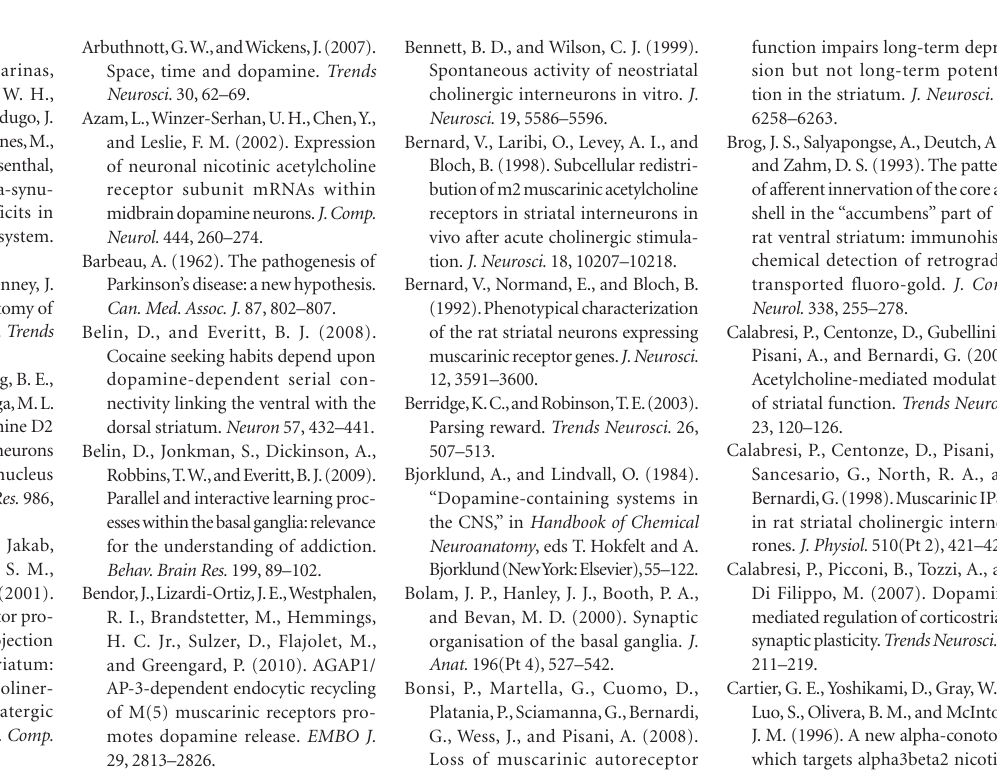
Figure 2 | Scheme illustrating cholinergic regulation of dopamine (DA) release during burst and non-burst activity in DA axons and nAChr/ mAChr subtypes responsible in CPu and NAc. Left, When mAChRs are inactive under control conditions, endogenous acetylcholine (ACh) released from tonically active striatal cholinergic interneurons (ChIs) maintains ACh tone at β 2*-nAChRs on dopaminergic axons. This tonic β 2*-nAChR activity ensures that DA release has a high probability of occurring in response to a single stimulus pulse. Short-term synaptic depression follows such DA release and limits re-release by successive pulses within bursts, i.e., DA release is insensitive to frequency. Center, Activation of mAChR autoreceptors on ChIs (e.g., with mAChR agonist Oxo-M) reduces ACh tone at β 2*-nAChRs on DA